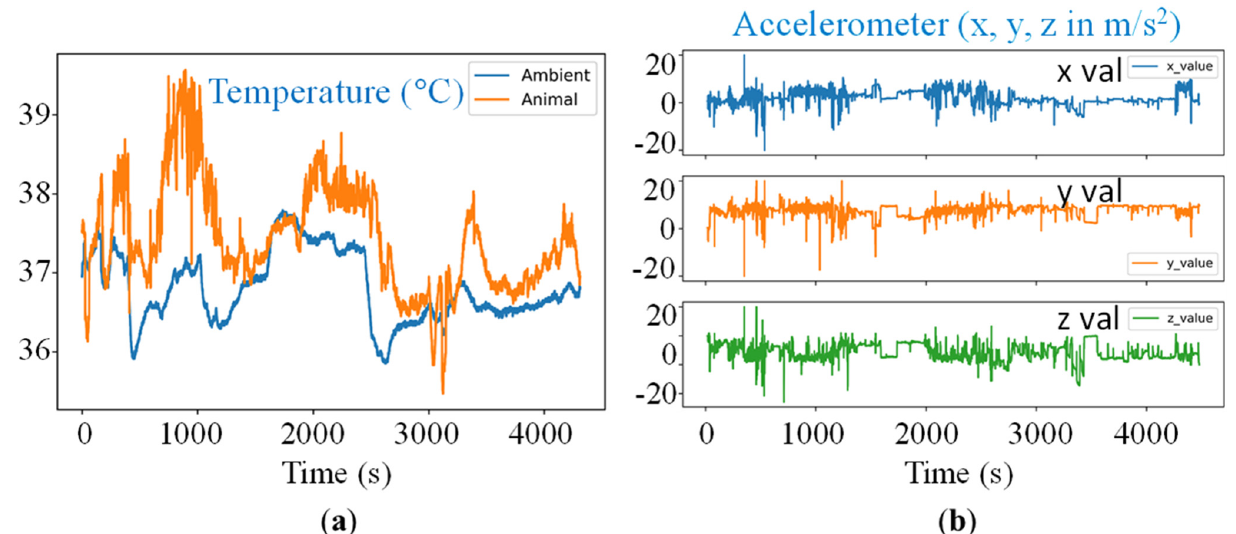
Figure 4. Time-series data recorded from pig testing using the electronic sensor board. Sample data from the animals is shown here as obtained from the on-board ( a ) temperature sensor and ( b ) 3-axis accelerometer. The sound sensors collected the baseline curves, but there were no useful events (e.g., coughing or screaming) during the recorded time period.